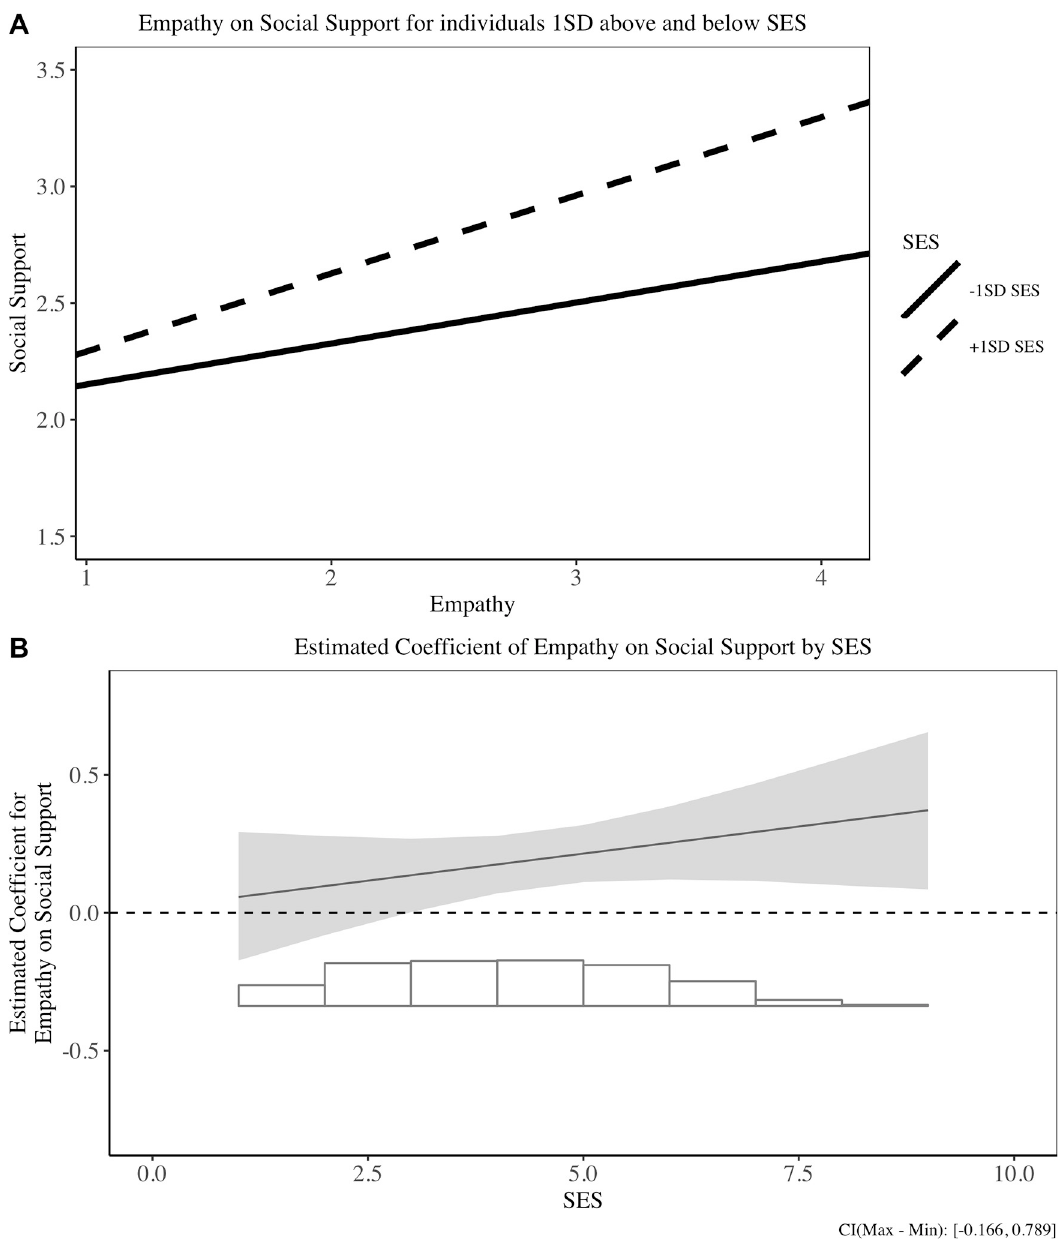
Fig 2. Relationship between empathy and social support in Study 1. (A) Simple slope result for +/- 1SD SES individuals on social support. (B) Estimated coefficient of empathy on social support for different SES individuals.